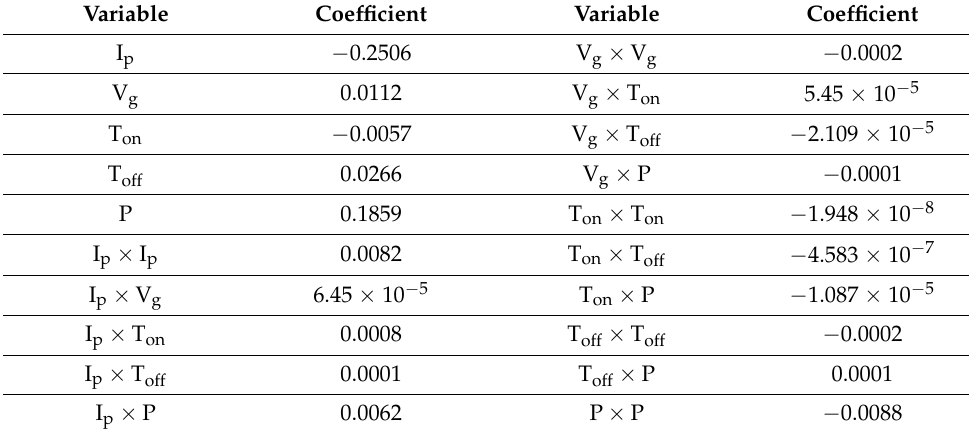
Table 3. Coefficients of variables for SR